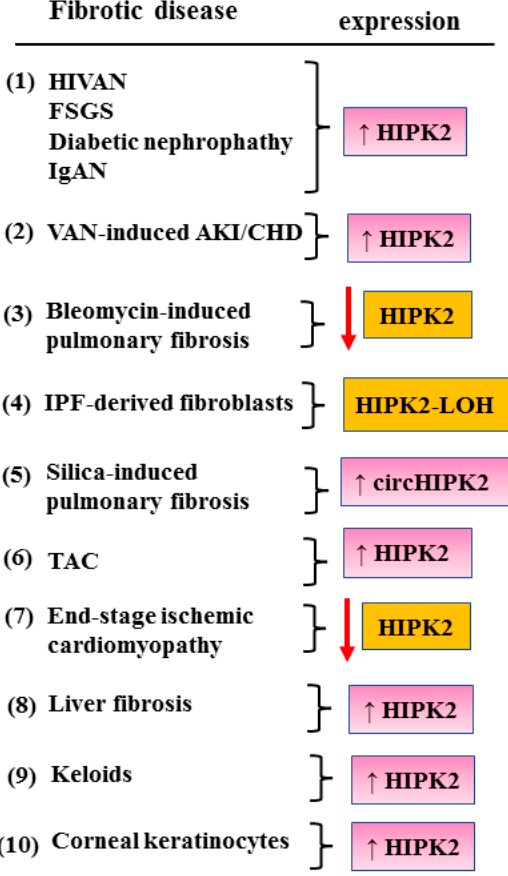
Figure 7. Summary of the HIPK2 expression in the several different fibrotic diseases discussed in the review. Black arrows indicate upregulation. Red arrows indicate downregulation. LOH = loss of heterozygosity.